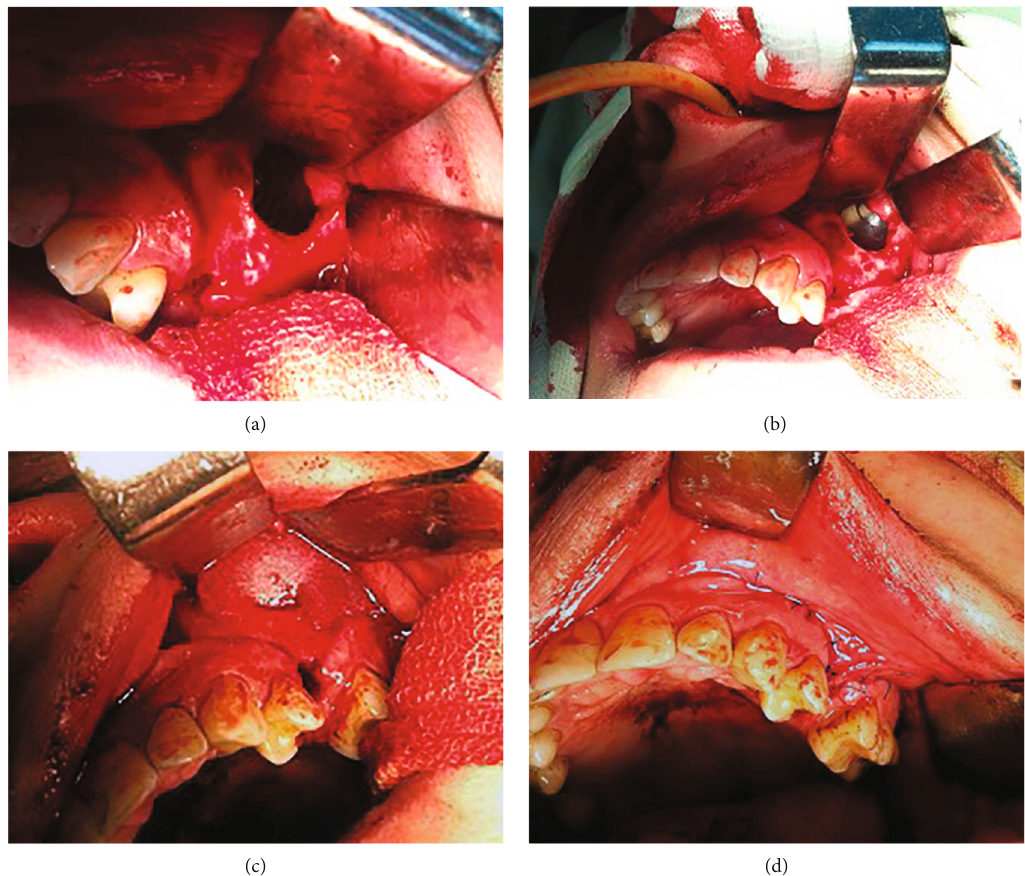
Figure 1: Surgical procedure: (a) sinus debridement through the created window; (b) insertion of the Foley catheter balloon into the sinus; (c) membrane placement over the window and the bony defect; (d) fl ap placement and suturing.